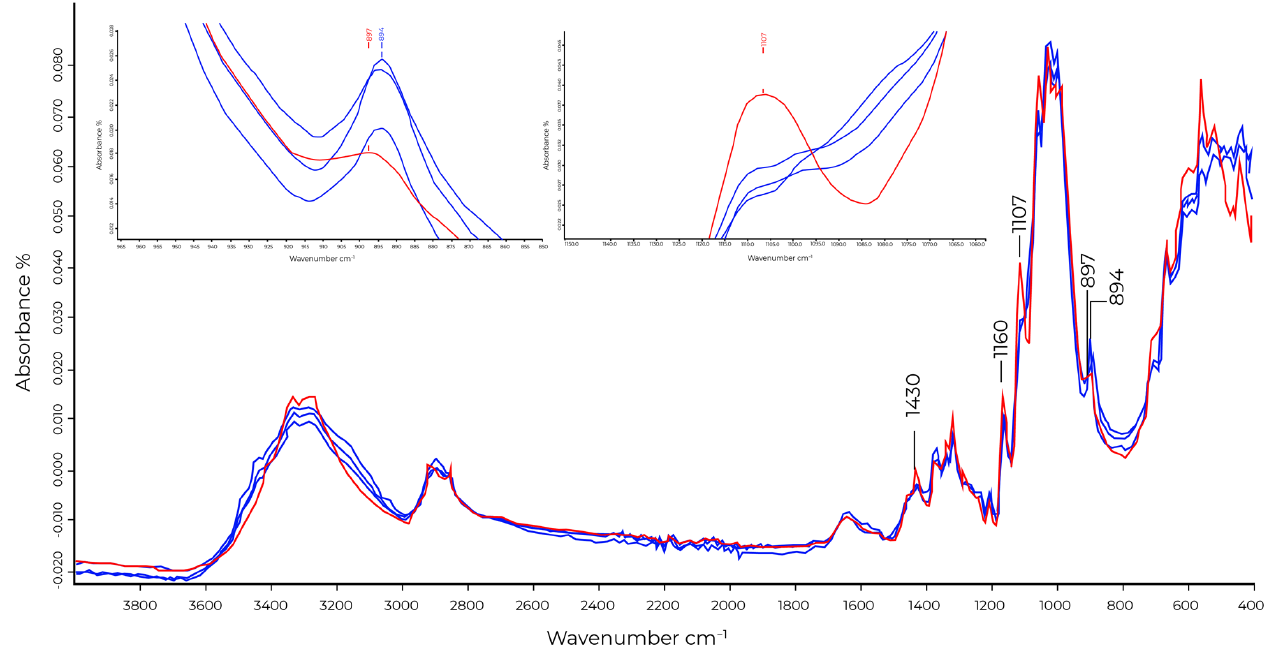
Figure 3. Full FTIR spectra of merceried pre-consumer samples in blue and reference 100% cotton sample in red; enlarged FTIR spectra of mercerised pre-consumer samples in blue, and reference 100% cotton sample in red with a change from 897 cm − 1 to 894 cm − 1 (top left); enlarged FTIR spectra of mercerised pre-consumer samples in blue, and reference 100% cotton sample in red: disappearance of the cotton peak in the mercerised samples at 1107 cm − 1 (top